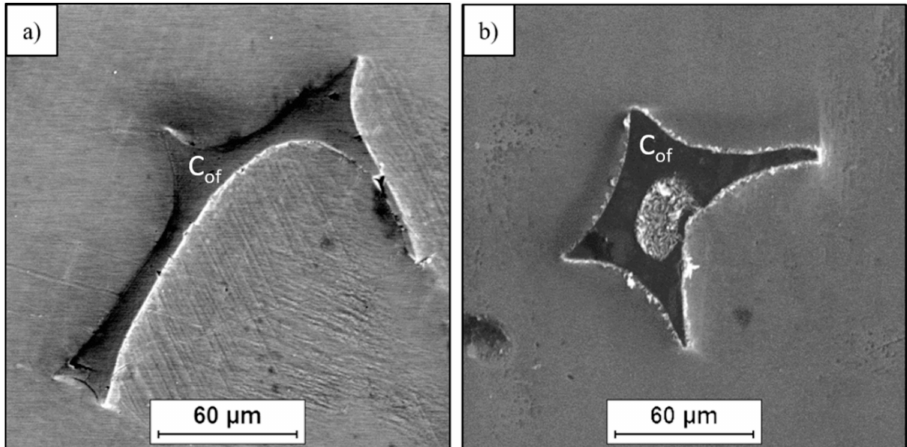
Figure 5. SEM micrographs of: ( a ) C of –Mg composite and ( b ) C of –AZ31 composite, visibly di ff erent morphology of the interface